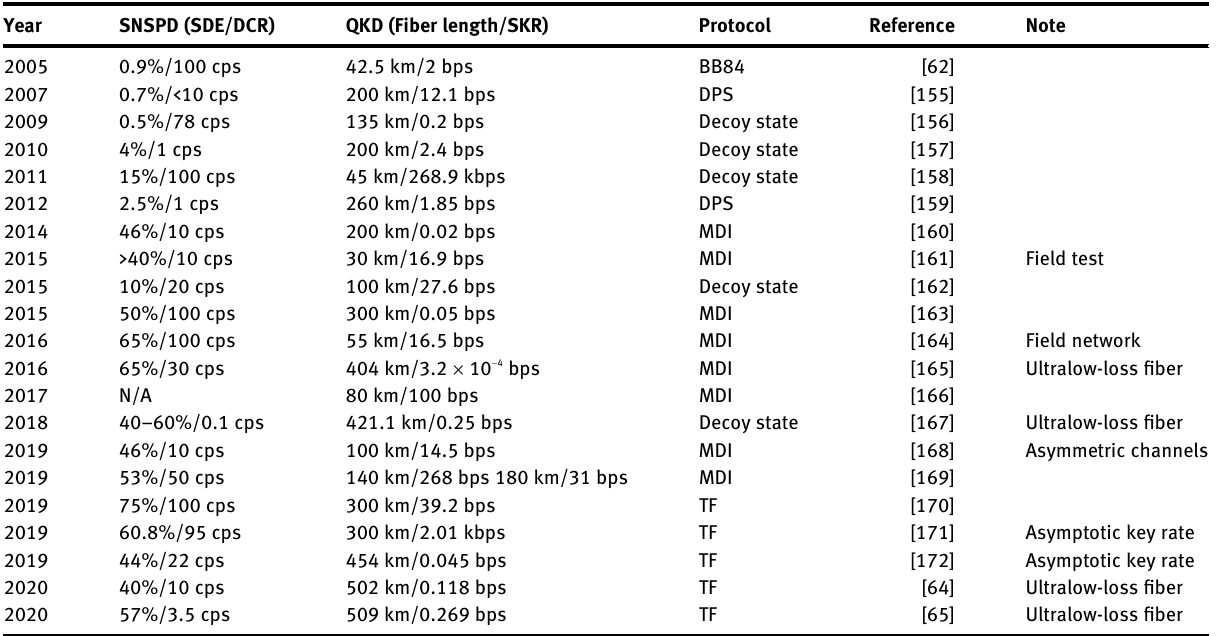
Table  : List of QKD experiments using SNSPDs.